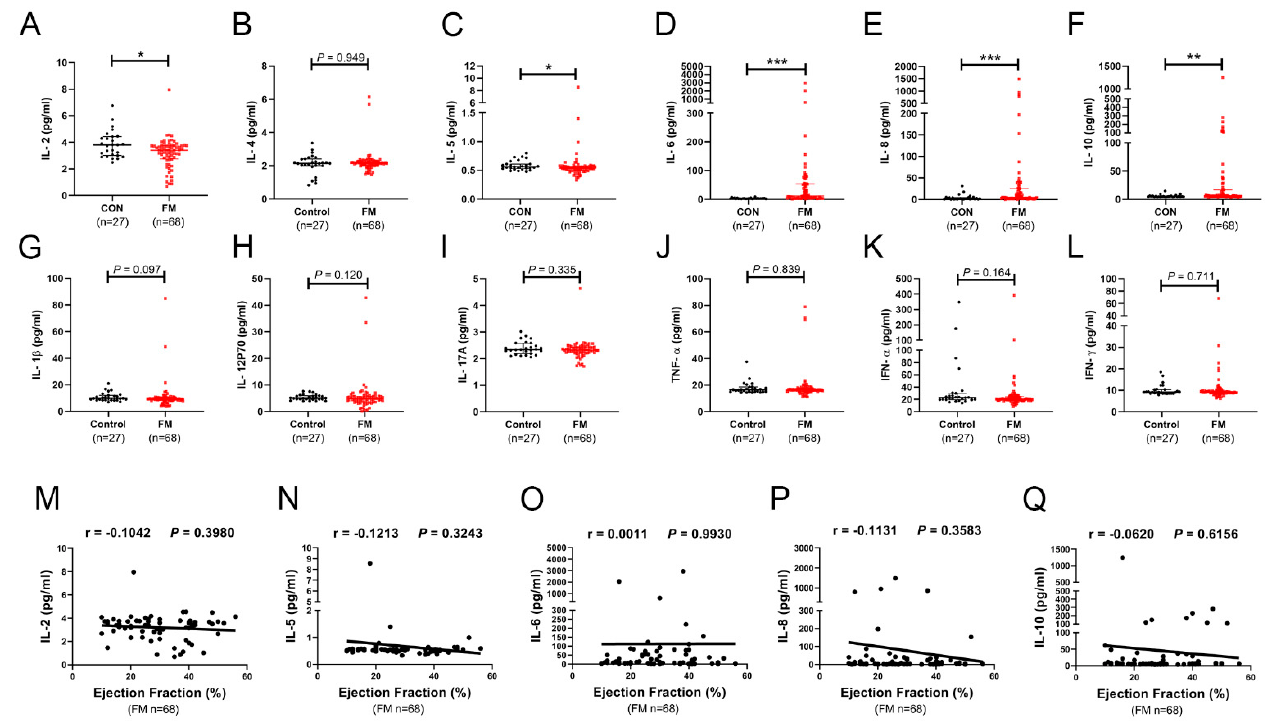
Figure 1. Plasma levels and correlation analysis of 12 common inflammatory cytokines in patients with fulminant myocarditis (FM). The plasma levels of IL-2 ( A ), IL-4 ( B ), IL-5 ( C ), IL-6 ( D ), IL-8 ( E ), IL-10 ( F ), IL-1 β ( G ), IL-12P70 ( H ), IL-17A ( I ), TNF- α ( J ), IFN- α ( K ), and IFN- γ ( L ) in patients with FM (n = 68) and healthy controls (n = 27) were detected using an ABplex human cytokine 12-Plex assay kit. Data are presented as medians and quartile 1 to quartile 3 [Q1–Q3], and a Mann–Whitney test was used to elevate the differences; * p < 0.05, ** p < 0.01, *** p < 0.001. Correlation analysis of plasma IL-2 ( M ), IL-5 ( N ), IL-6 ( O ), IL-8 ( P ), and IL-10 ( Q ) with ejection fraction values in 68 patients with FM. r indicates the correlation coefficient. Table 1. Baseline clinical characteristics of human cytokine 12-Plex assay detection cohort and hu- man cytokine arrays analysis validation cohort.